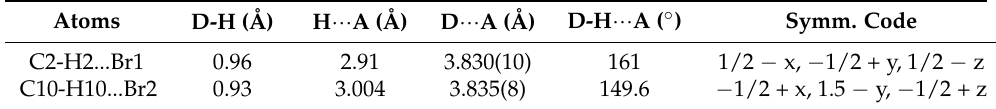
Figure 3. Important contacts ( A ) and packing scheme ( B ) in the [Cd(BPMT)Br 2 ] complex. Table 3. Hydrogen-bond parameters in the [Cd(BPMT)Br 2 ] complex.